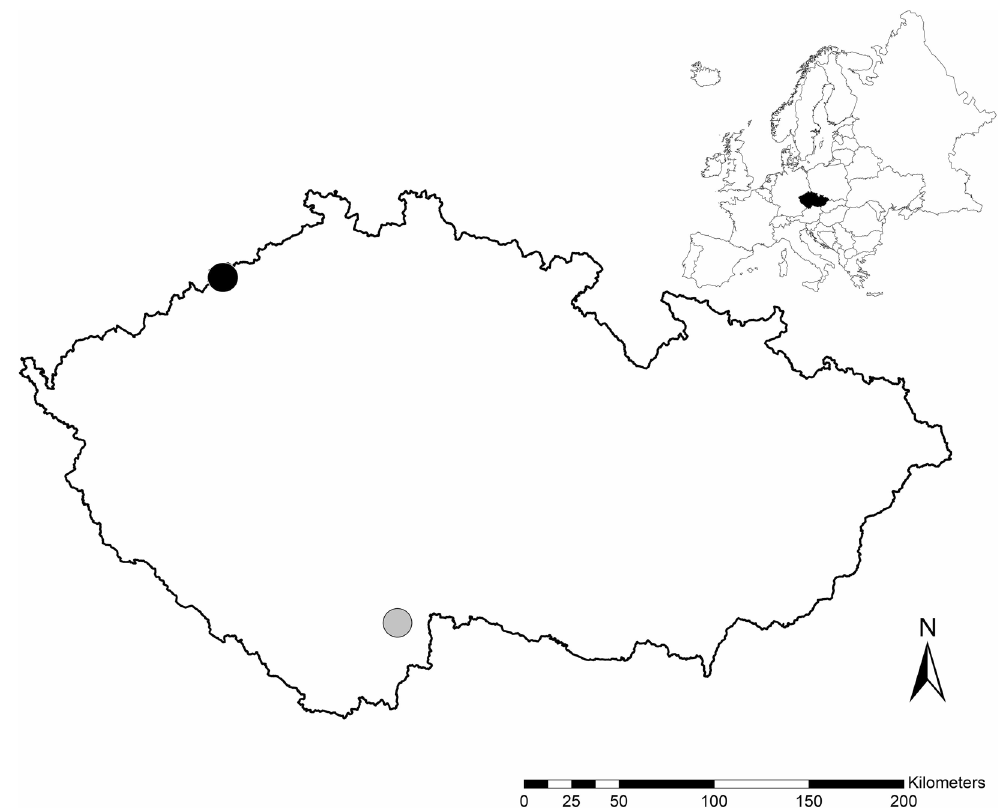
Figure 1. Two study areas in the Czech Republic: a historically air-polluted area in the Ore Mts. (51°N, 14°E, black point) and a protected landscape area in the Trebon Basin (49°N, 15°E; grey point).